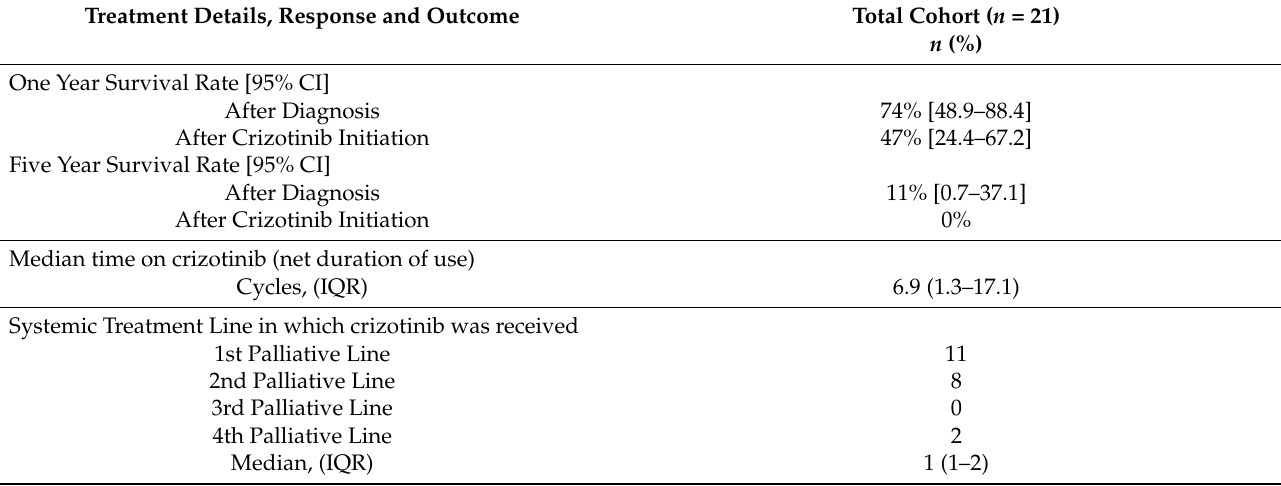
Table A2. Clinical response and outcome for ROS1-rearranged NSCLC on